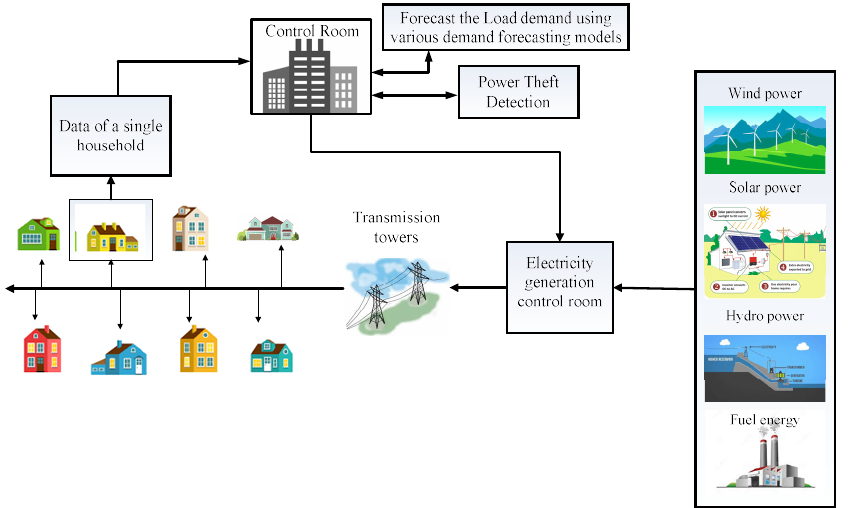
Figure 1. Architecture of the energy demand forecasting system.